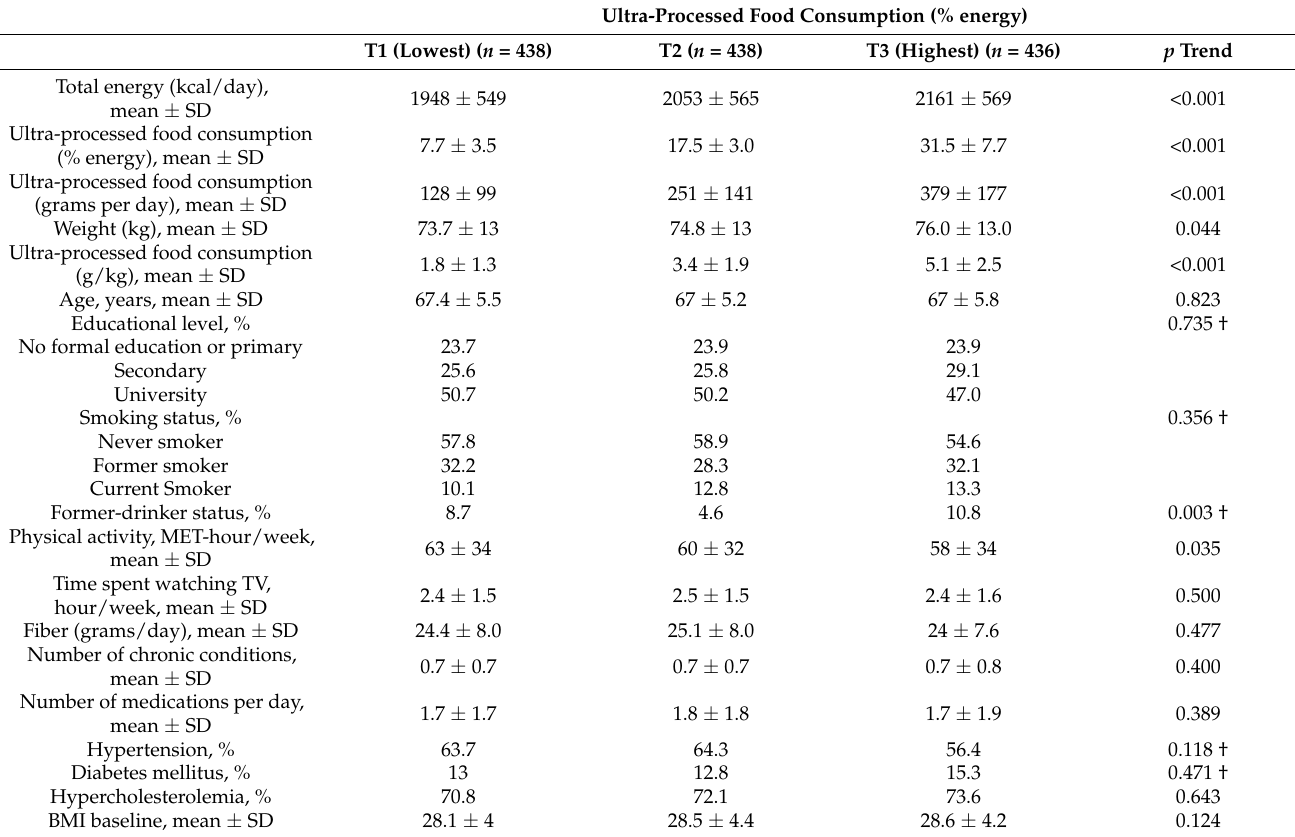
Table 1. Baseline characteristics of the cohort participants according to sex-specific terciles of Ultra-processed Food Consumption as a percentage of total energy (% energy), in the Seniors-ENRICA Cohort Study ( n =